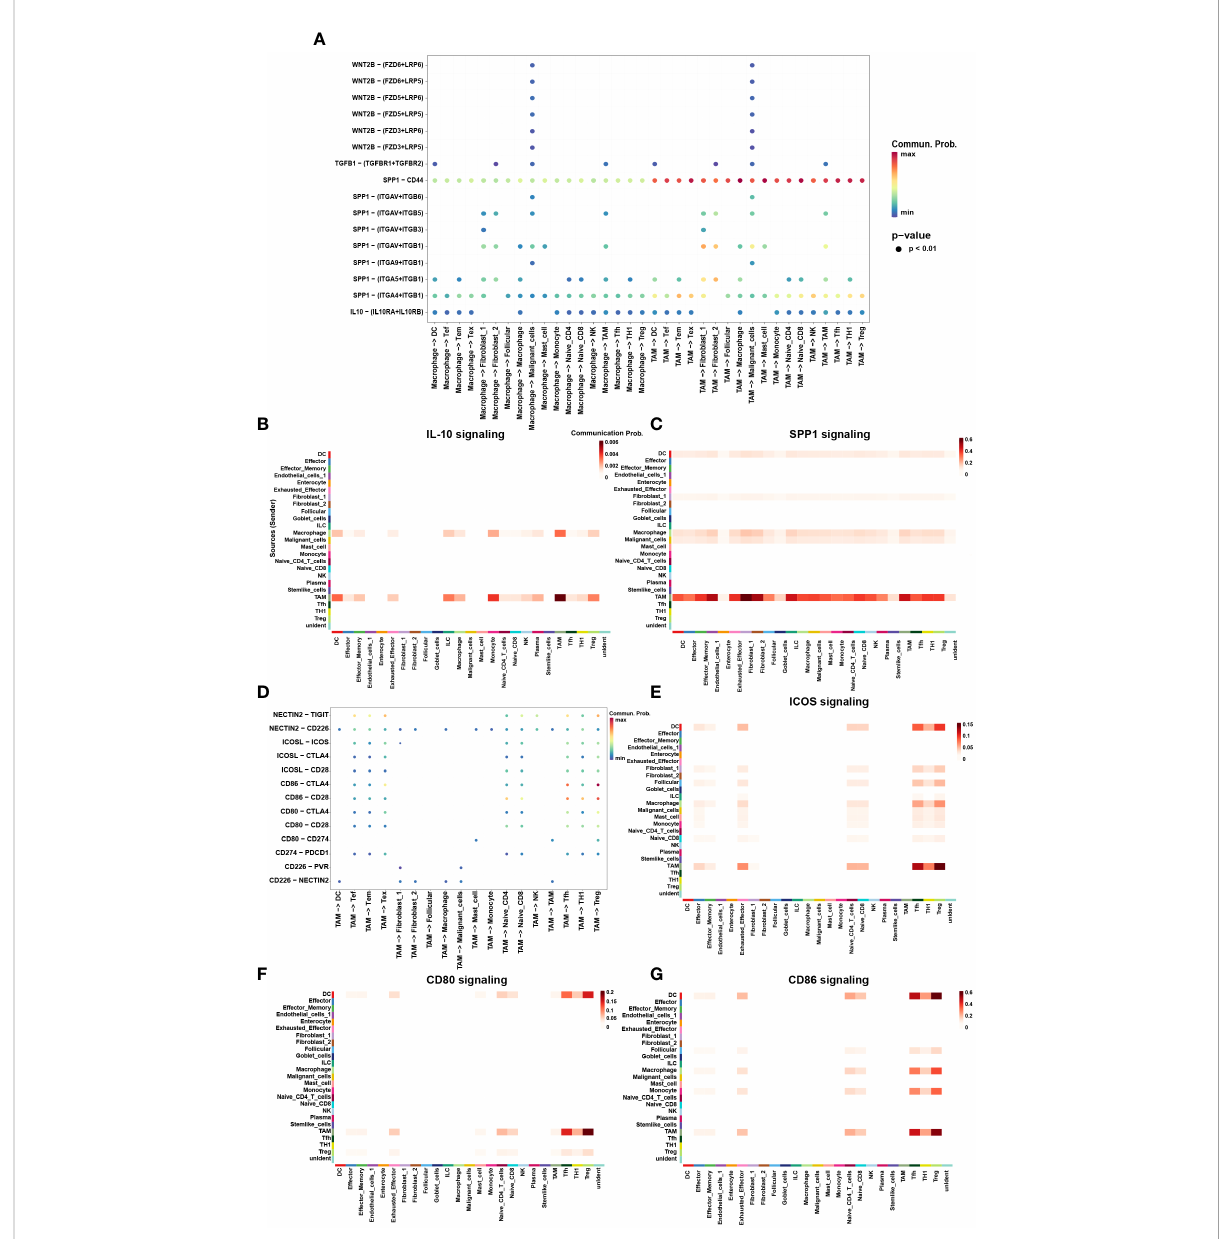
FIGURE 5 The interaction network of macrophages and TAMs. (A) Summary of selected soluble factor-receptor interactions among macrophages, TAMs and TME-in fi ltrated cell types. (G) Summary of selected immune checkpoints-receptor interactions between TAMs and TME-in fi ltrated cell clusters. P-values are represented by the size of each circle. The color gradient indicates the level of interaction; blue and red colors correspond to the smallest and largest values respectively. (B, C, E – G) The heatmap plot showed the inferred intercellular communication network for SPP1 (B) and IL-10 (C) , CD80 (E) , CD86 (F) , and ICOSL (G) signaling of myeloid cells and TME-in fi ltrated cell clusters, respectively. The interactions are divided into sources (labeled on y-axis) and targets (labeled on x-axis). The color gradient represents the communication probability; white and red colors correspond to the smallest and largest values